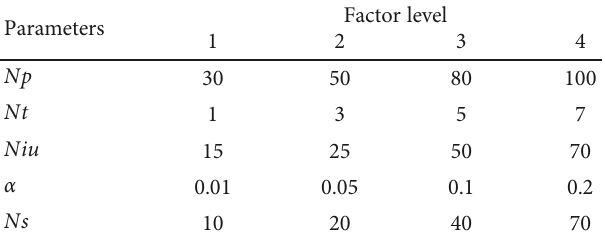
Table 12: Combination of parameters values. Parameters